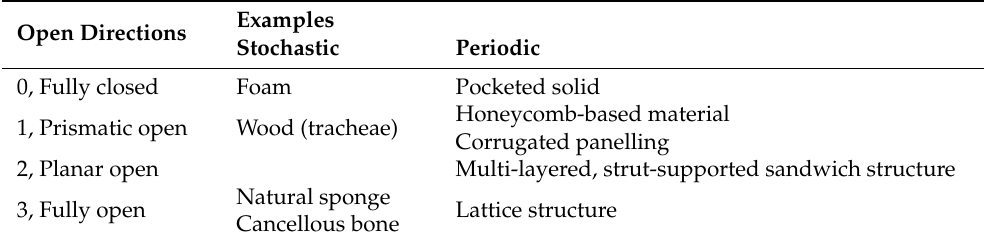
Table 1. Classification of cellular material topologies by open direction and